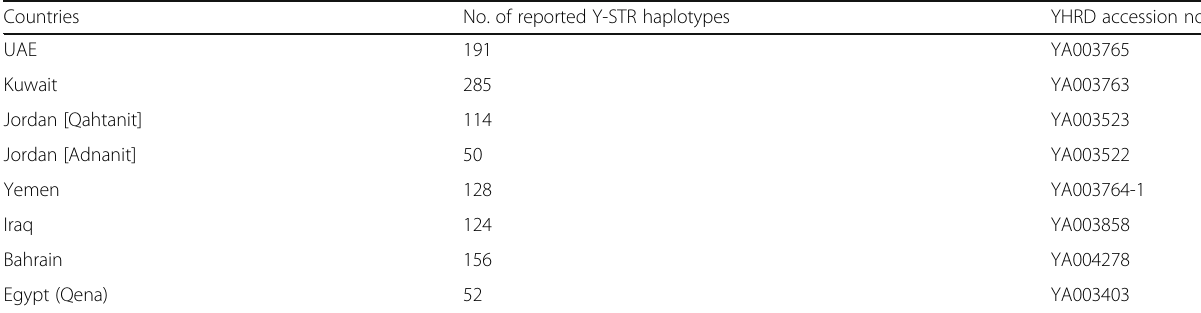
Table 1 Neighboring Arab population ’ s reported Y-STR haplotypes and corresponding YHRD accession number